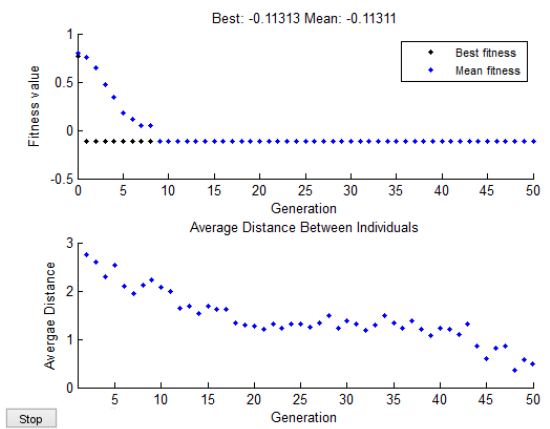
Fig. 9. Best fitness value for :; trajectory and average distance between individuals.